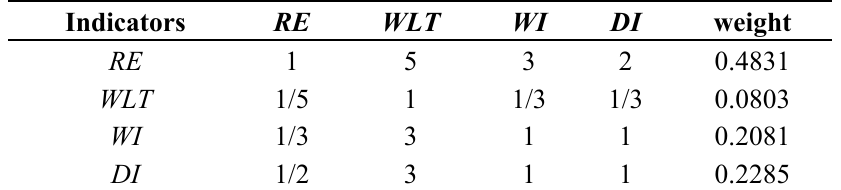
Table A3. The pair-wise comparison matrix for indicators of operational activity.